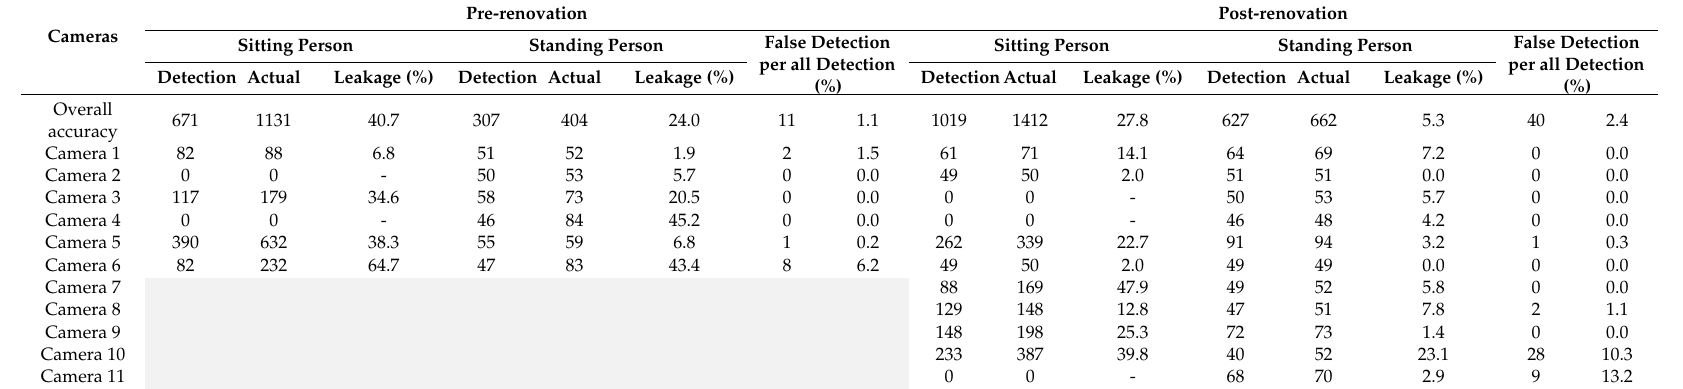
Table A1. Accuracy of each camera for detecting sitting or standing